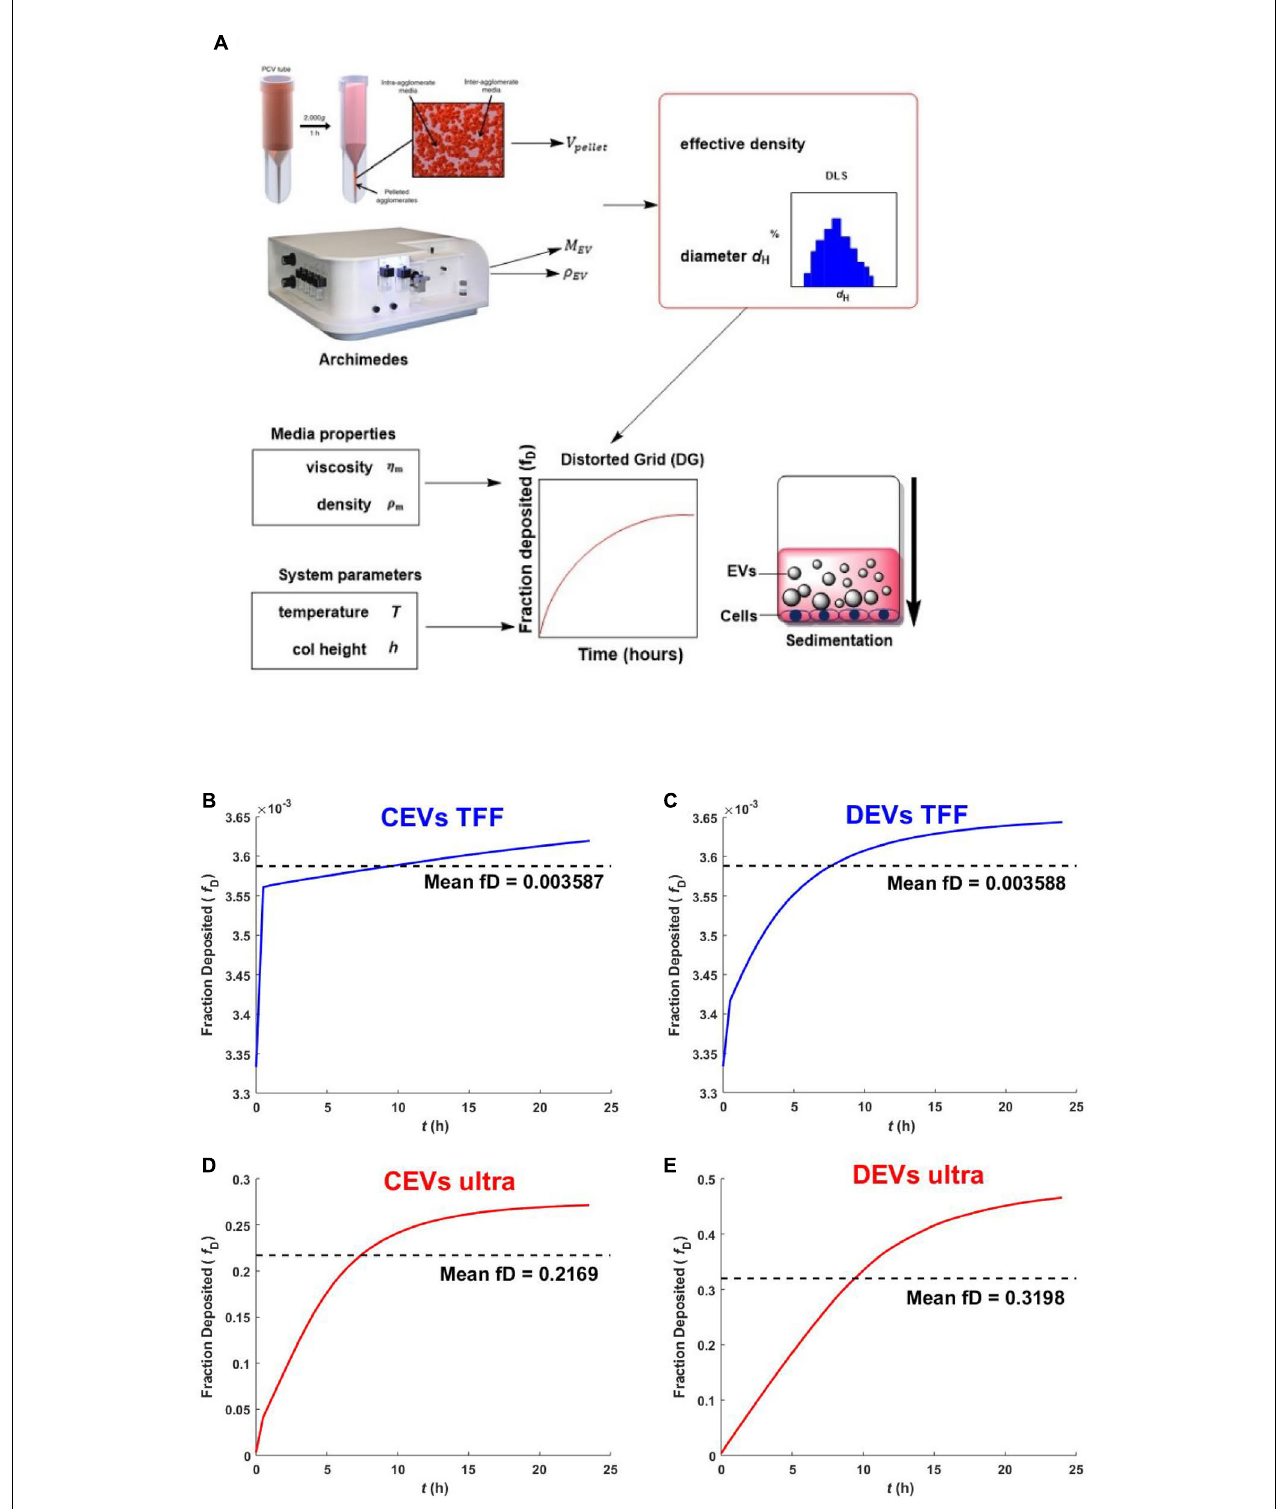
FIGURE 4 | Schematic overview of nanodosimetry approach and the predicted fraction deposited of EVs. The schematic overview of DG modeling adapted from DeLoid et al. (2017) (A) . The predicted fraction deposited of CEVs isolated using (B) TFF and (D) ultracentrifugation; DEVs isolated using (C) TFF and (E) ultracentrifugation into each well in a 96-well plate was generated by Matlab. Mean fD is the mean fraction deposited.